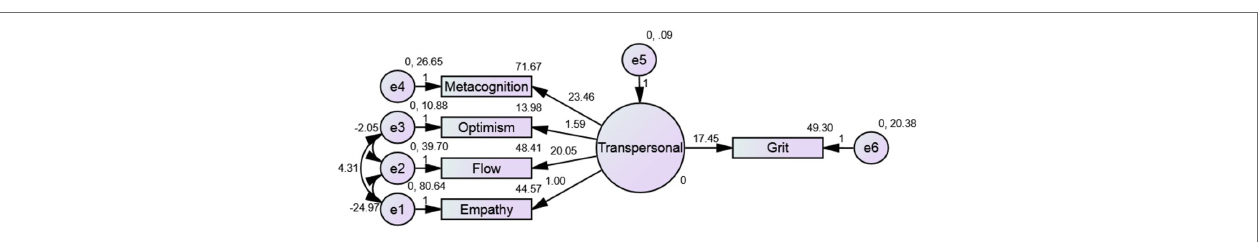
FIGURE 1 | Confirmatory factor analysis of antecedents of grit.